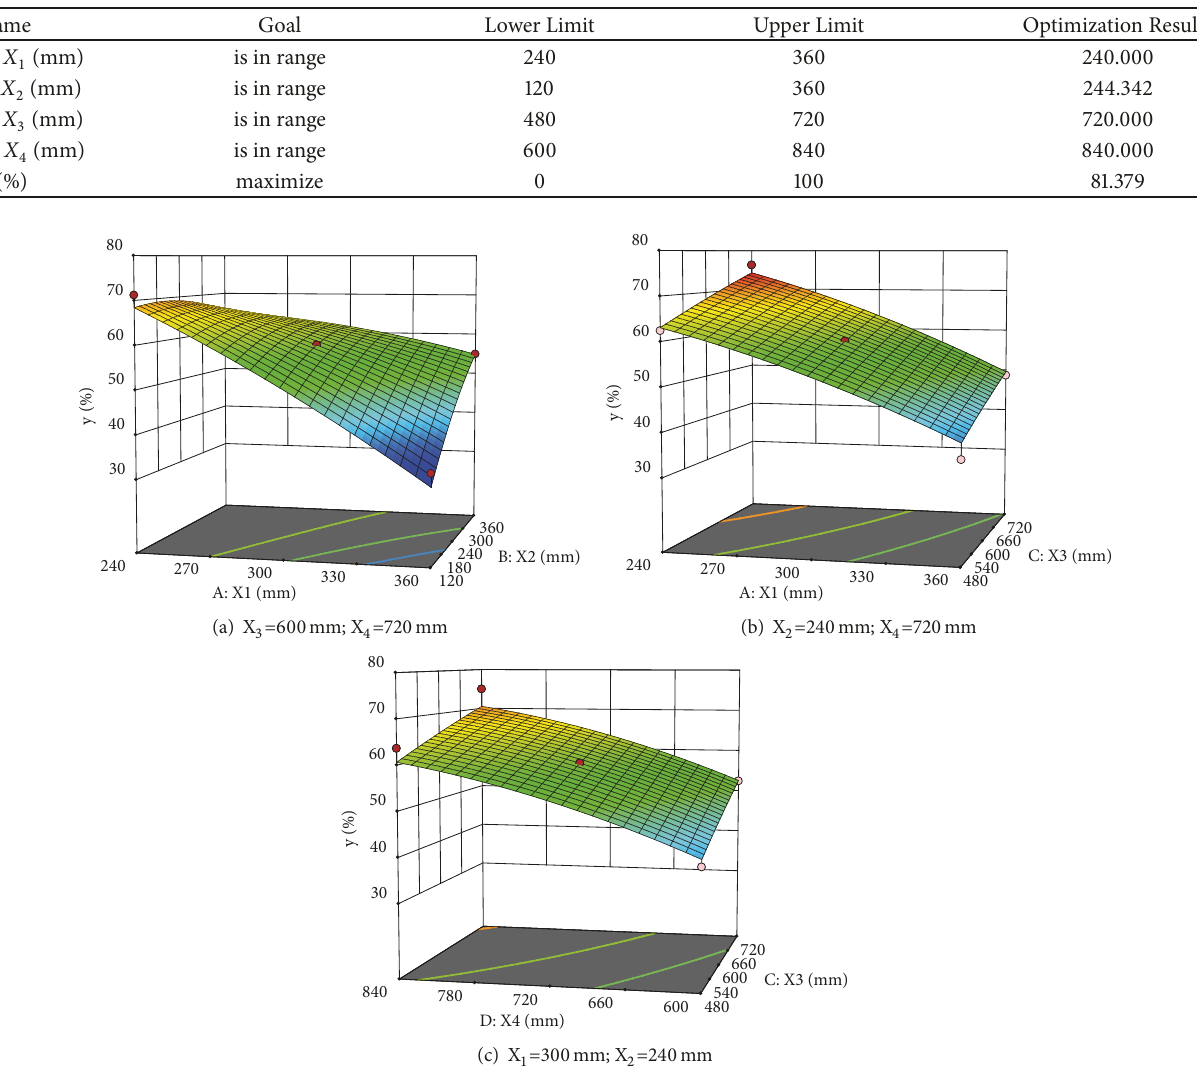
Table 8: Optimization constraints and results.